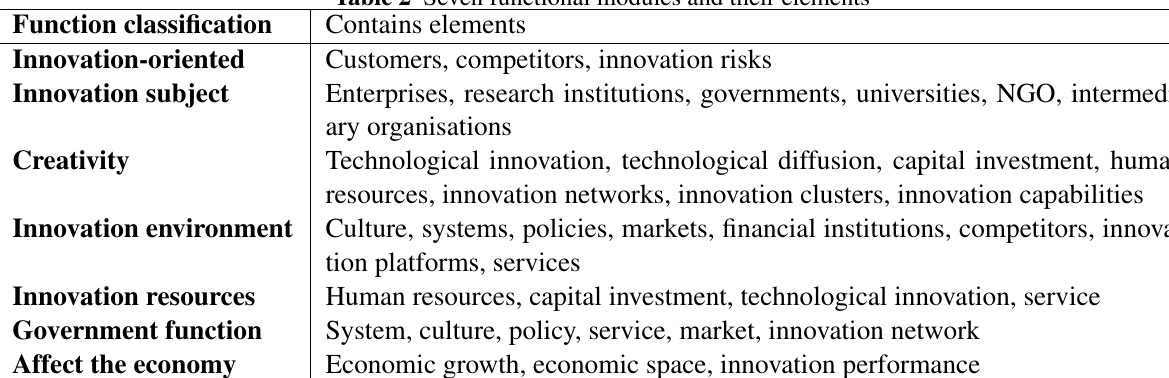
Fig. 2 Seven functional modules of the collaborative innovation system Table 2 Seven functional modules and their